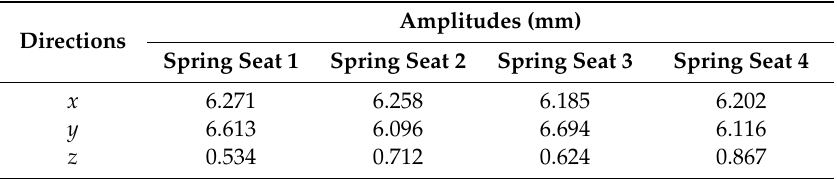
Table5. Thesteadystateamplitudesoffourspringseatsinthe x , y ,and z directionsundernormalconditions.